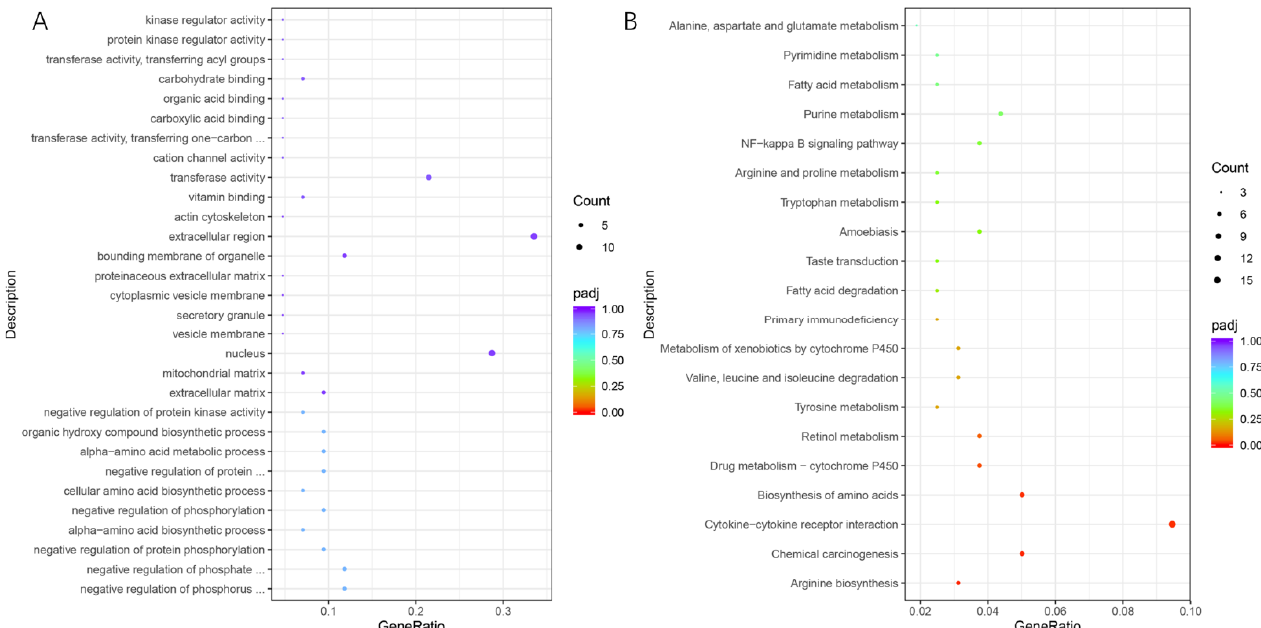
Figure 2. Enrichment of gene ontology (GO) terms ( A ) and KEGG pathways ( B ) in HL vs. LL. HL, liver samples of the high-EF group; LL, liver samples of the low-EF group.